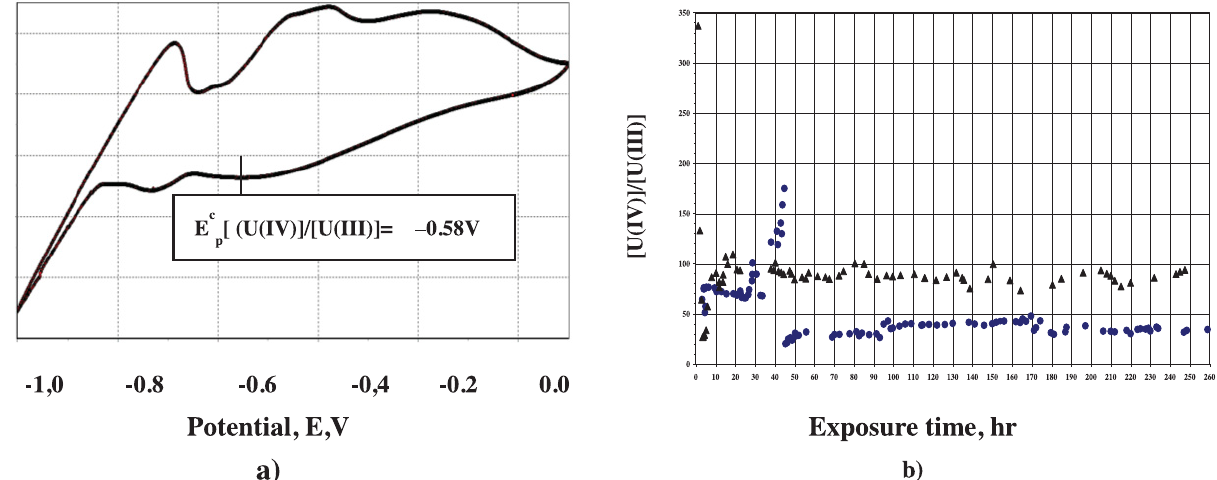
Fig. 2. CV of the fuel salt at T = 700 ° C after its puri fi cation before the corrosion test (a) and the [U(IV)]/[U (III)] ratio vs. exposure time (b) for: ● fi rst and ▲ second tests